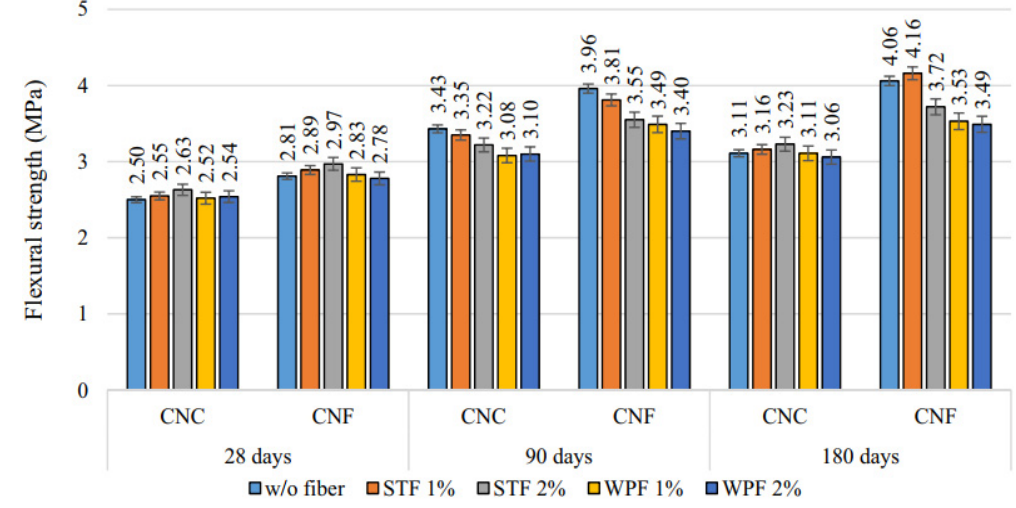
Figure 6. FS of control mix containing natural coarse aggregate (CNC) and control mix containing natural fine aggregate (CNF) with and without fiber [74]. Steel fiber (STF); waste plastic fiber (WPF).